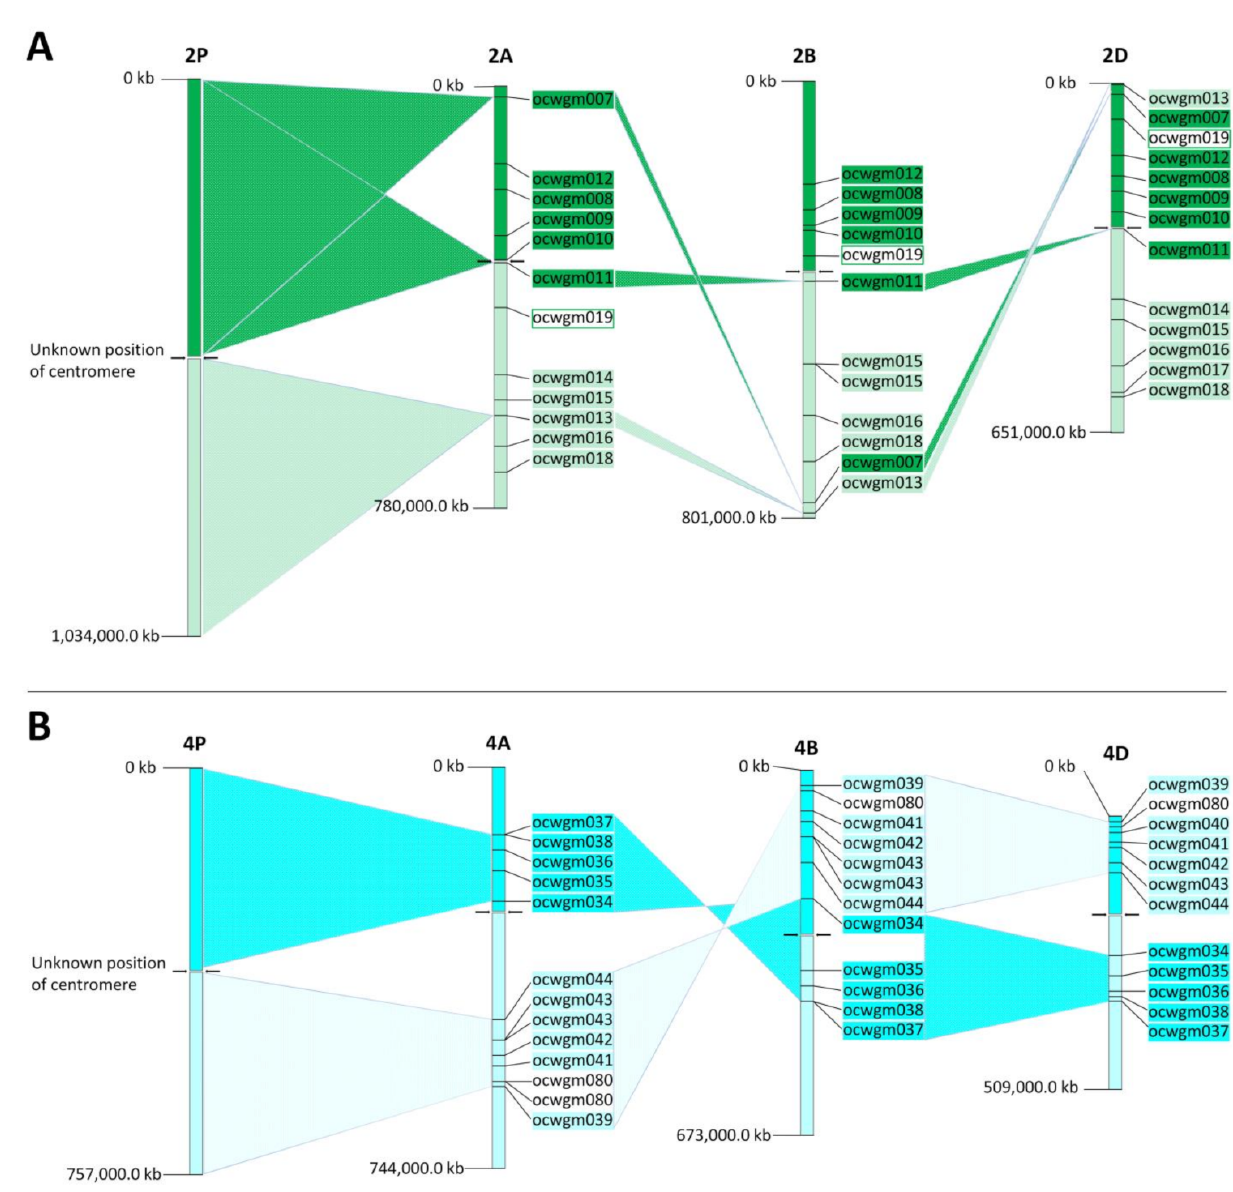
Figure 4. Rearrangements specific for chromosome group 2 between A. cristatum and common wheat [46] ( A ), and rearrangements specific for chromosome group 4 between A. cristatum and common wheat [46] ( B ), as revealed by newly developed SSR